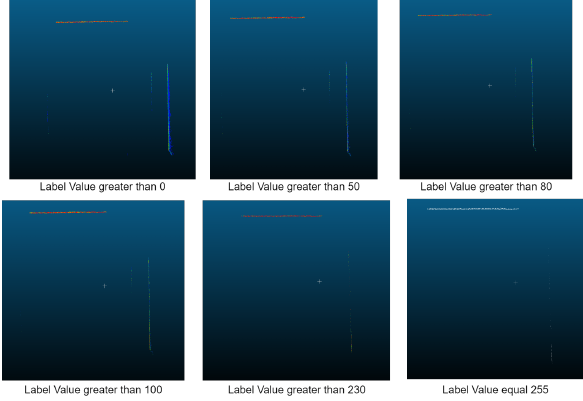
Figure 10. Label values threshold